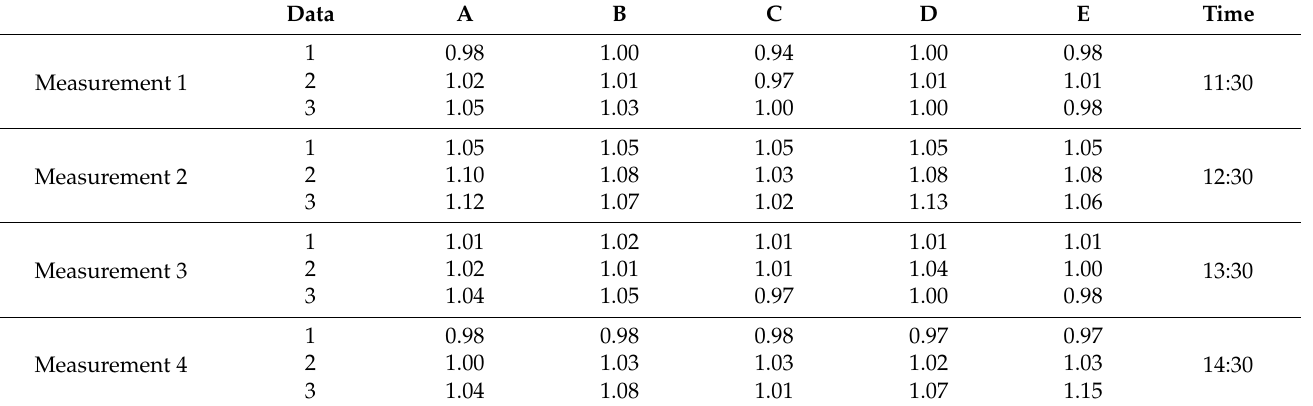
Table 3. Radiation ratios with galvanized steel side panels and installation of aluminum mirrors on inclined canal